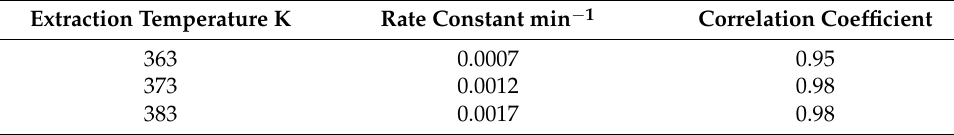
Table 4. Co leaching rate constants at different temperatures.